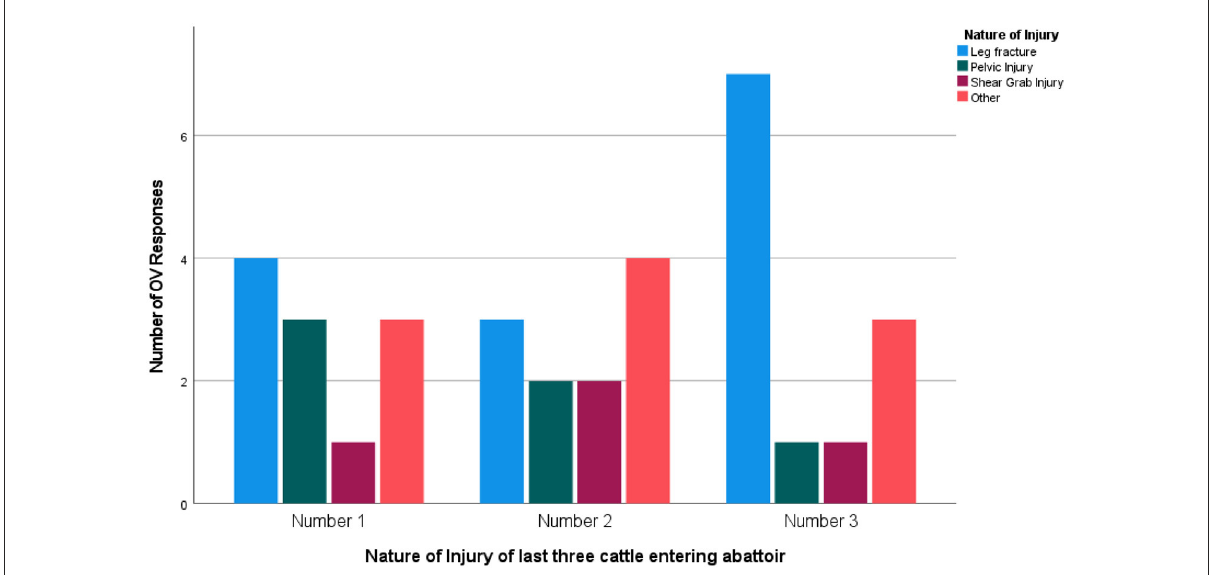
FIGURE3 The type of acute injury reported by Official Veterinarians ( n = 13) for the last three cattle certified for casualty slaughter in